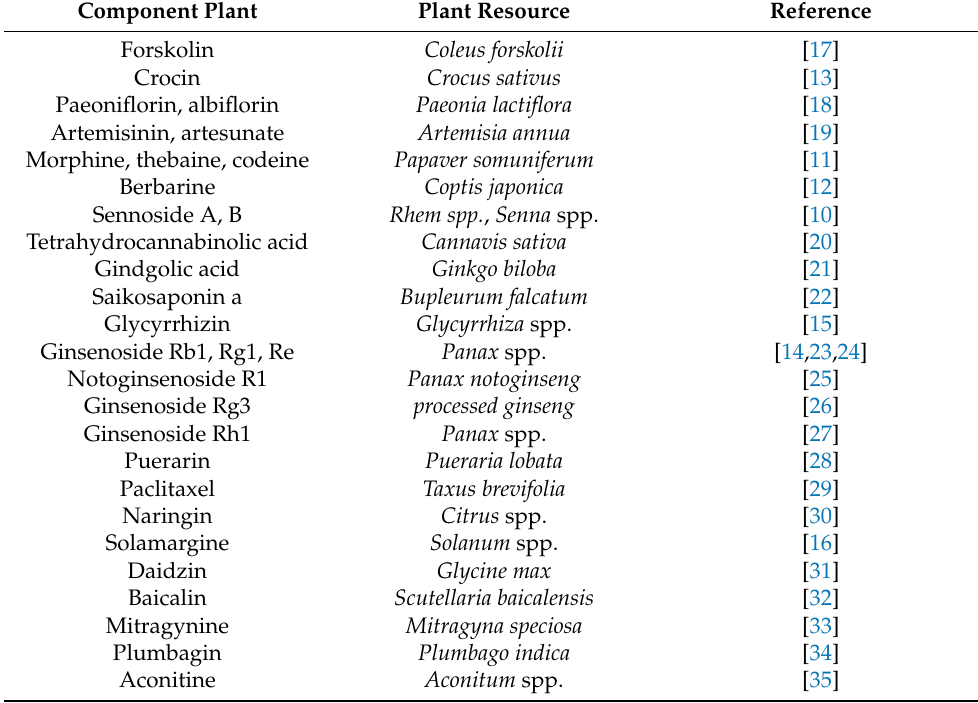
Table 1. Monoclonal antibodies against natural